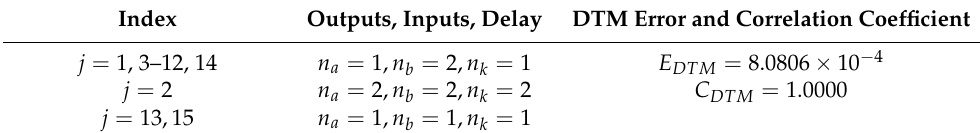
Table 2. Initial data for NLARX estimator of temporal coefficients, case of Re = 10 2 , N DMD = 15.